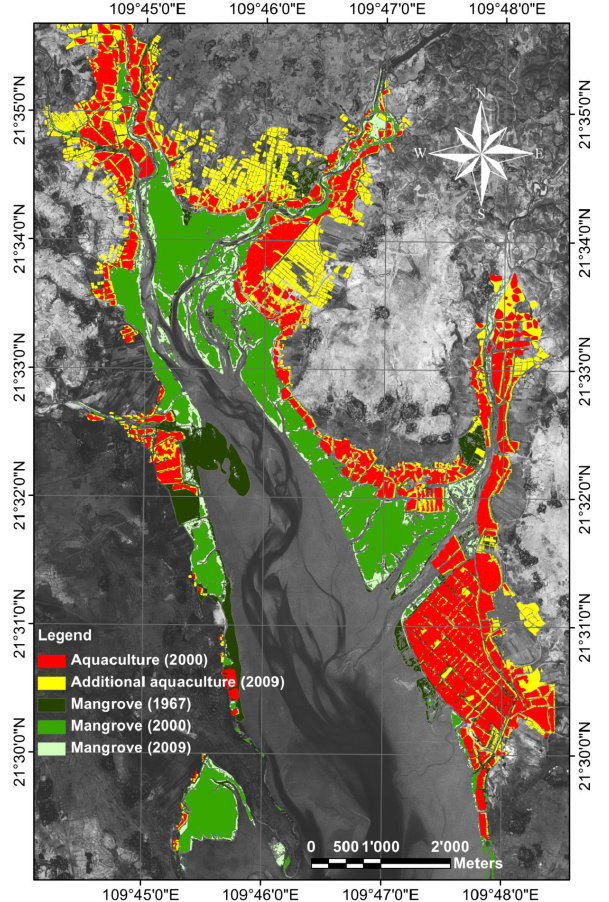
Fig. 2. Changes in Gaoqiao mangrove cover observed from 1967 Figure 2. Changes in Gaoqiao mangrove cover observed from 1967 (Corona), 2000 (Landsat) 2 (Corona), 2000 (Landsat) and 2009 (GeoEye-1) satellite data and and 2009 (GeoEye-1) satellite data and expansion of aquaculture ponds observed from 2000 3 expansion of aquaculture ponds observed from 2000 (Landsat) and 2009 (GeoEye-1) satellite data (background: 1967 Corona im- (Landsat) and 2009 (GeoEye-1) satellite data (background: 1967 Corona imagery). 4 agery).